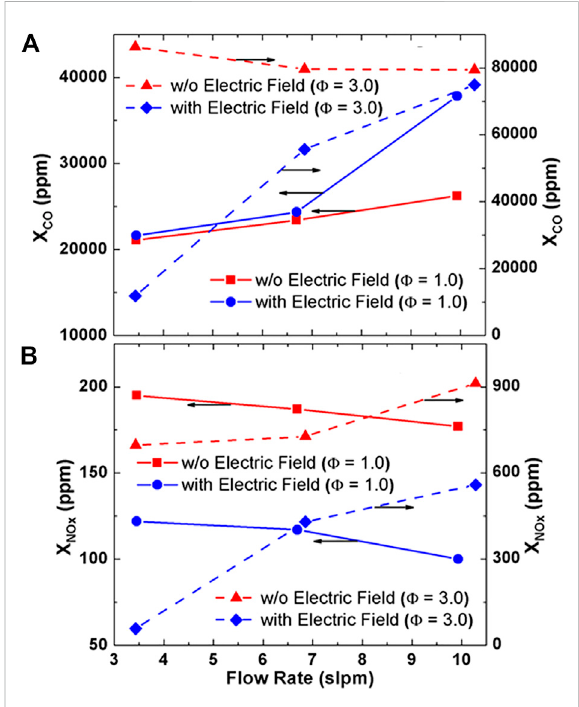
Comparisons of maximum (A) CO and (B) NO x in the domain fordifferent fl owrateconditionwithandwithoutelectric fi eldfora premixed CH 4 /air mixture for two different equivalence ratio. Applied voltage 50 kV.